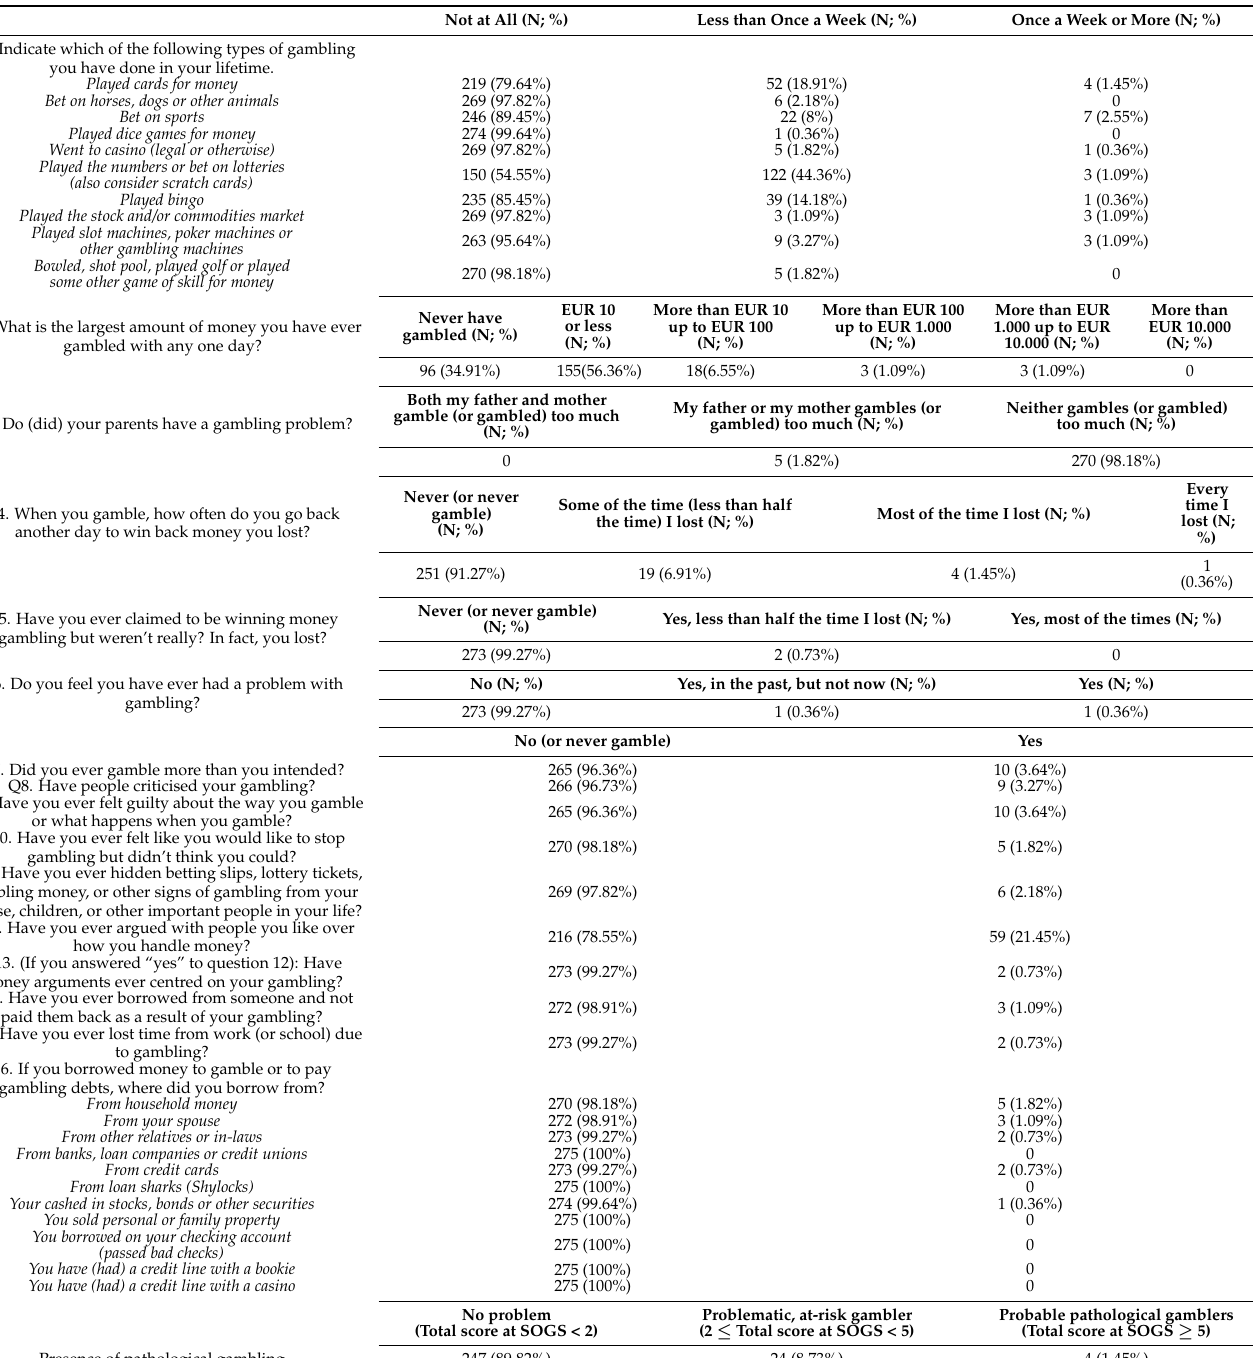
Table 2. Answers to the SOGS questionnaire (from question 1 to